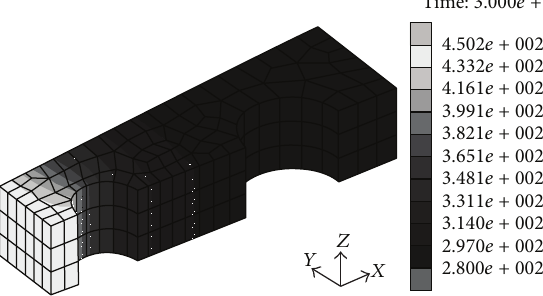
Figure 4: FEM model of graphite brick and temperature distribu- tion at EOL (unit: ∘